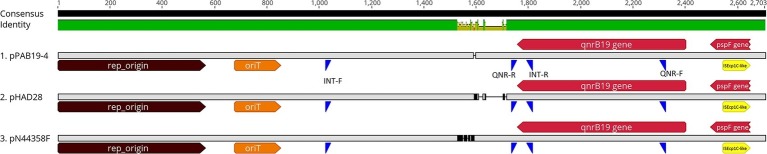
Linear representation of plasmids carrying the qnrB19 gene. Plasmids pPAB19-4, pHAD28, and pN44358F were selected to represent different clusters resulting from the phylogenetic analysis (Supplementary Figure S1). Alignment was crafted with the ClustalW plug-in in Geneious Prime 2019 using default parameters. Consensus identity bar: green represents 100% identity among all sequences, green-brown indicates 30 to <100% identity, and red shows <30% identity. Genomic features are represented by different colors; brown: plasmid origin of replication (rep_origin; nt 1-564); orange: Origen of transfer (oriT; nt 677-851); red: genes qnrB-19 (nt 2,402-1,758) and gene pspF (nt2,647-2,496); yellow: ISEcp1C-like insertion sequence (nt 2,512-2,409). Primer alignment sites are represented in blue: INT-F and INT-R represent primers for the intergenic region. QNR-F and QNR-R represent primers for the qnrB-19 gene region.